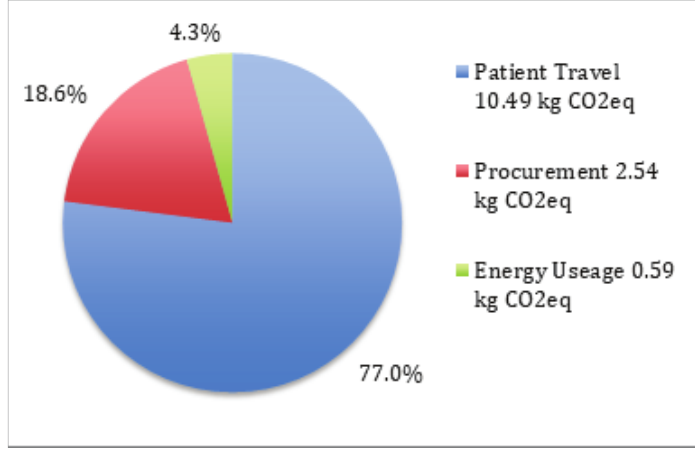
Figure 1. Proportional carbon emissions. Kg CO2eq, kilograms of carbon dioxide equivalents